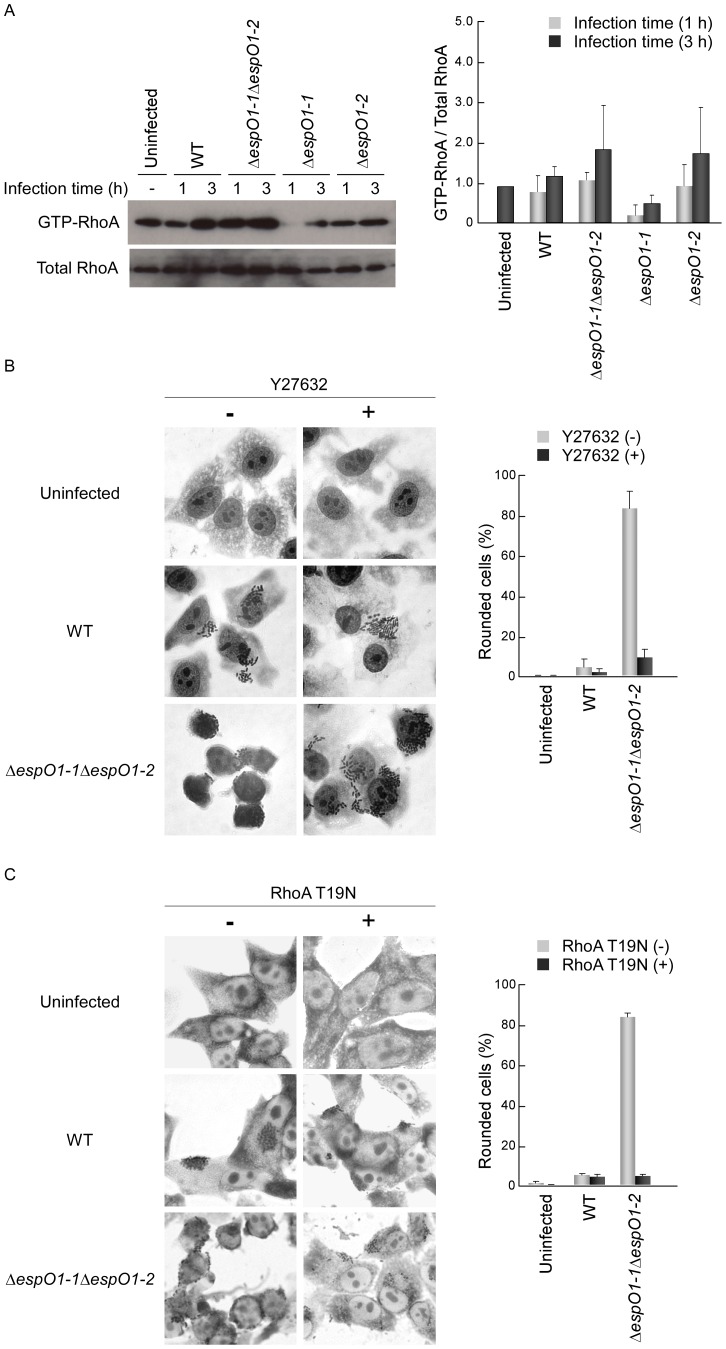
Enhancement of RhoA signaling activity induces cell rounding.(A) Involvement of EspO1-1 and EspO1-2 in the RhoA-ROCK signaling pathway in EHEC-infected cells. HeLa cells were infected with the EHEC WT, an ΔespO1-1ΔespO1-2 double mutant, an ΔespO1-1 mutant or an ΔespO1-2 mutant. At 1 and 3 h post-infection, a sample of cells was lysed and GTP-RhoA, the active form of RhoA, was co-precipitated with the GST-Rho binding domain (RBD) of rhotekin. The amount of RhoA bound to RBD (GTP-RhoA) and total RhoA in each cell lysate was analyzed by immunoblotting with anti-RhoA antibodies. The intensity of bands was quantified using the Image J program, and the results are expressed as fold increases in the ratio for GTP-RhoA/Total RhoA in uninfected cells (n = 3). (B) Effect of the ROCK inhibitor Y27632 on the morphological change of EHEC-infected cells. Untreated HeLa cells and HeLa cells treated with Y27632 for 1 h were infected with EHEC WT or the ΔespO1-1ΔespO1-2 double mutant. At 3 h post-infection, the cells were fixed and stained with Giemsa. The percent of cell rounding in cells infected by WT or ΔespO1-1ΔespO1-2 was quantified (>50 cells, n≥3). (C) Effect by expression of dominant-negative RhoA (T19N) in transfected cells on the morphological change of EHEC-infected cells. HeLa cells transfected with GFP or GFP-tagged RhoA T19N were infected with EHEC WT or the ΔespO1-1ΔespO1-2 double mutant at 48 h post-transfection. At 3 h post-infection, the cells were fixed and stained with Giemsa. The percent of cell rounding in cells infected by WT or ΔespO1-1ΔespO1-2 was quantified (>50 cells, n≥3).